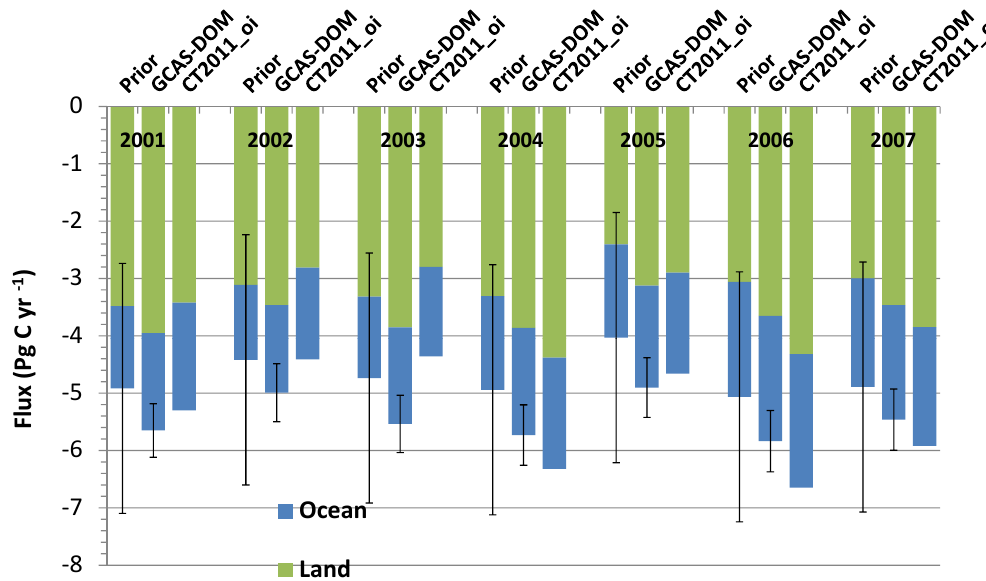
Figure 5. Annual fluxes for the land and ocean from 2001 to 2007 in comparison with results of CT2011_oi. “Prior” and “GCAS-DOM” are the fluxes before and after optimization. Black horizontal lines denote the uncertainties of global flux. The uncertainties of global flux from CT2011_oi are on average about 6PgCyr − 1 which is not shown in this figure. All units are in PgCyr − 1 . Fossil fuel and fire emissions are excluded here.